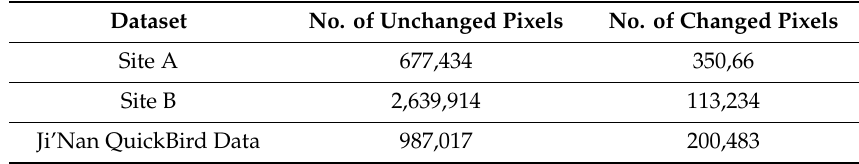
Table 1. Details of ground reference pixels for each dataset.